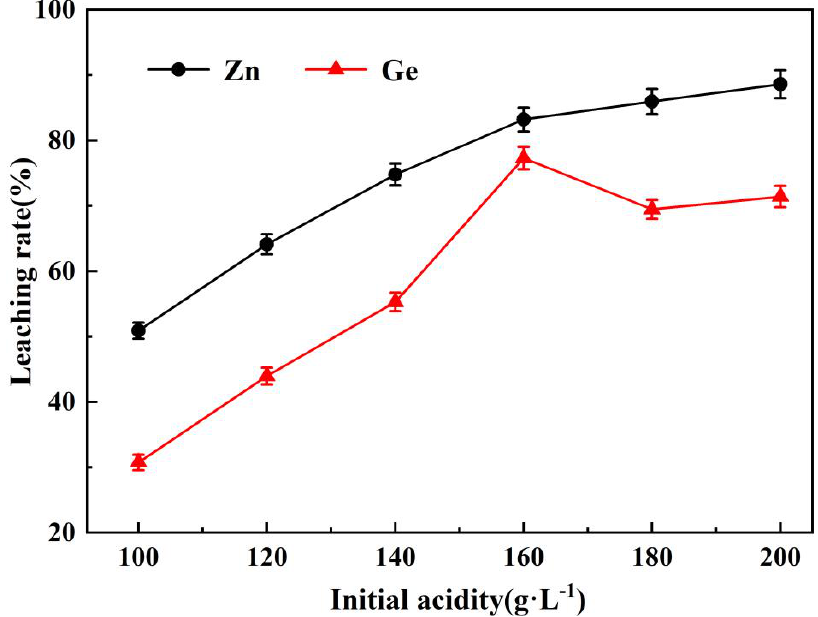
Figure 9. Effect of initial acidity on metal leaching rate (L/S mass ratio = 5:1, leaching time = 60 min, leaching temperature = 90 °C, and stirring speed = 400 r·min − 1 ).